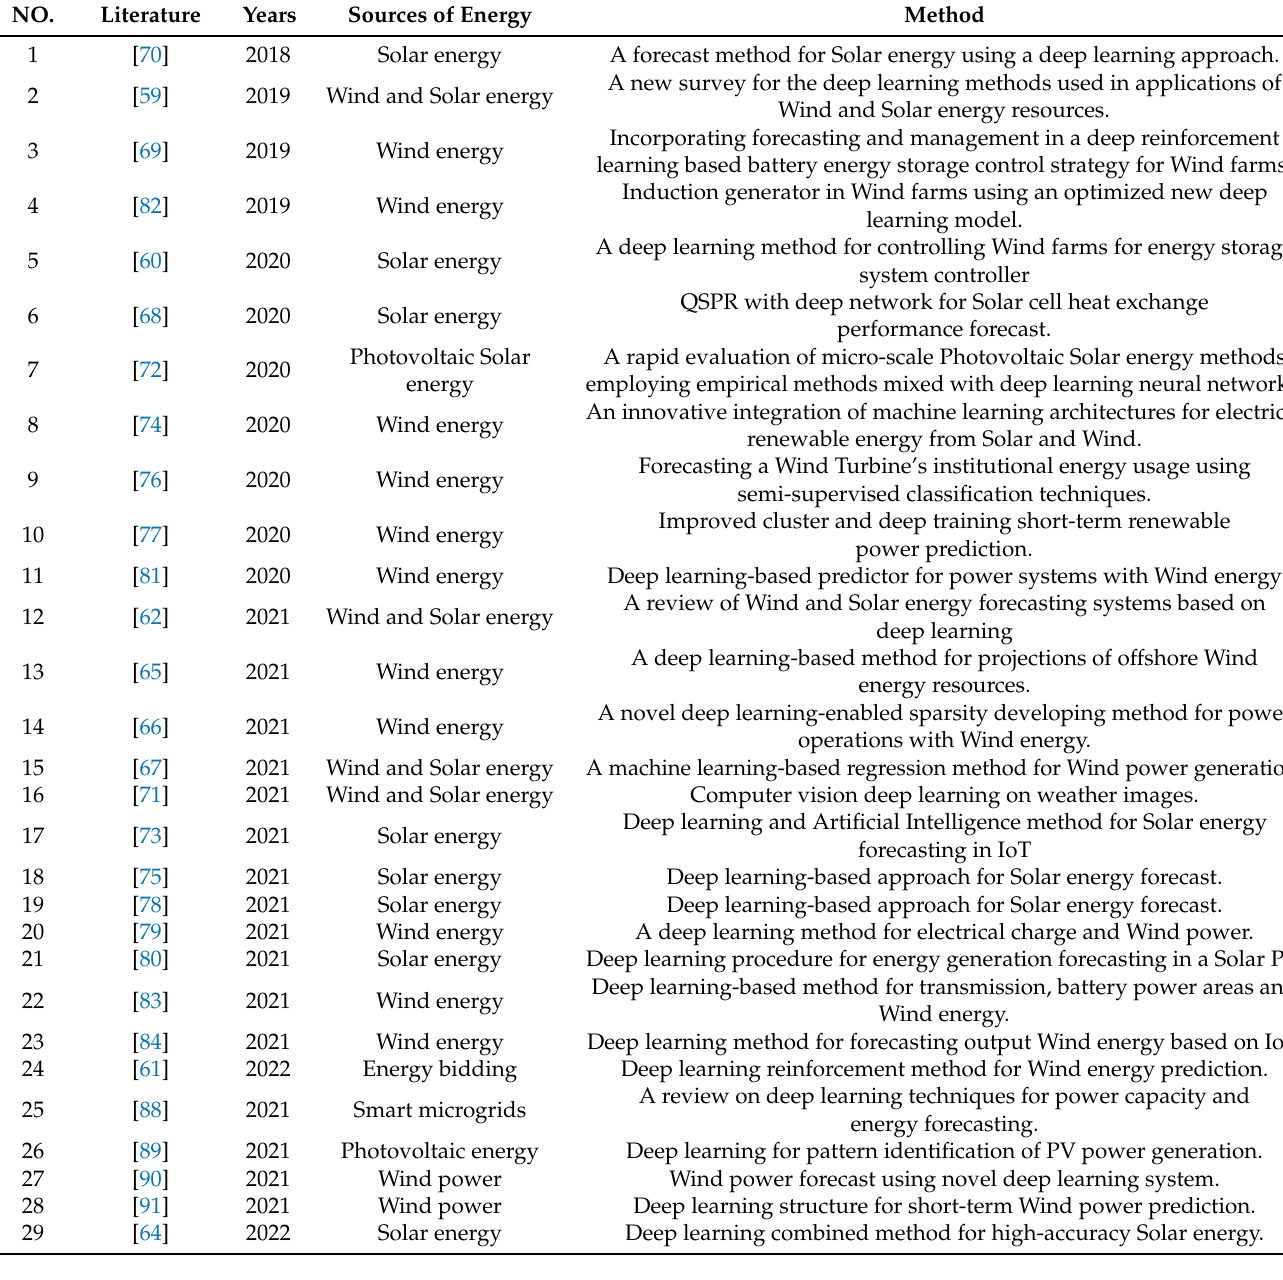
Table 3. An overview of applying deep learning techniques to renewable